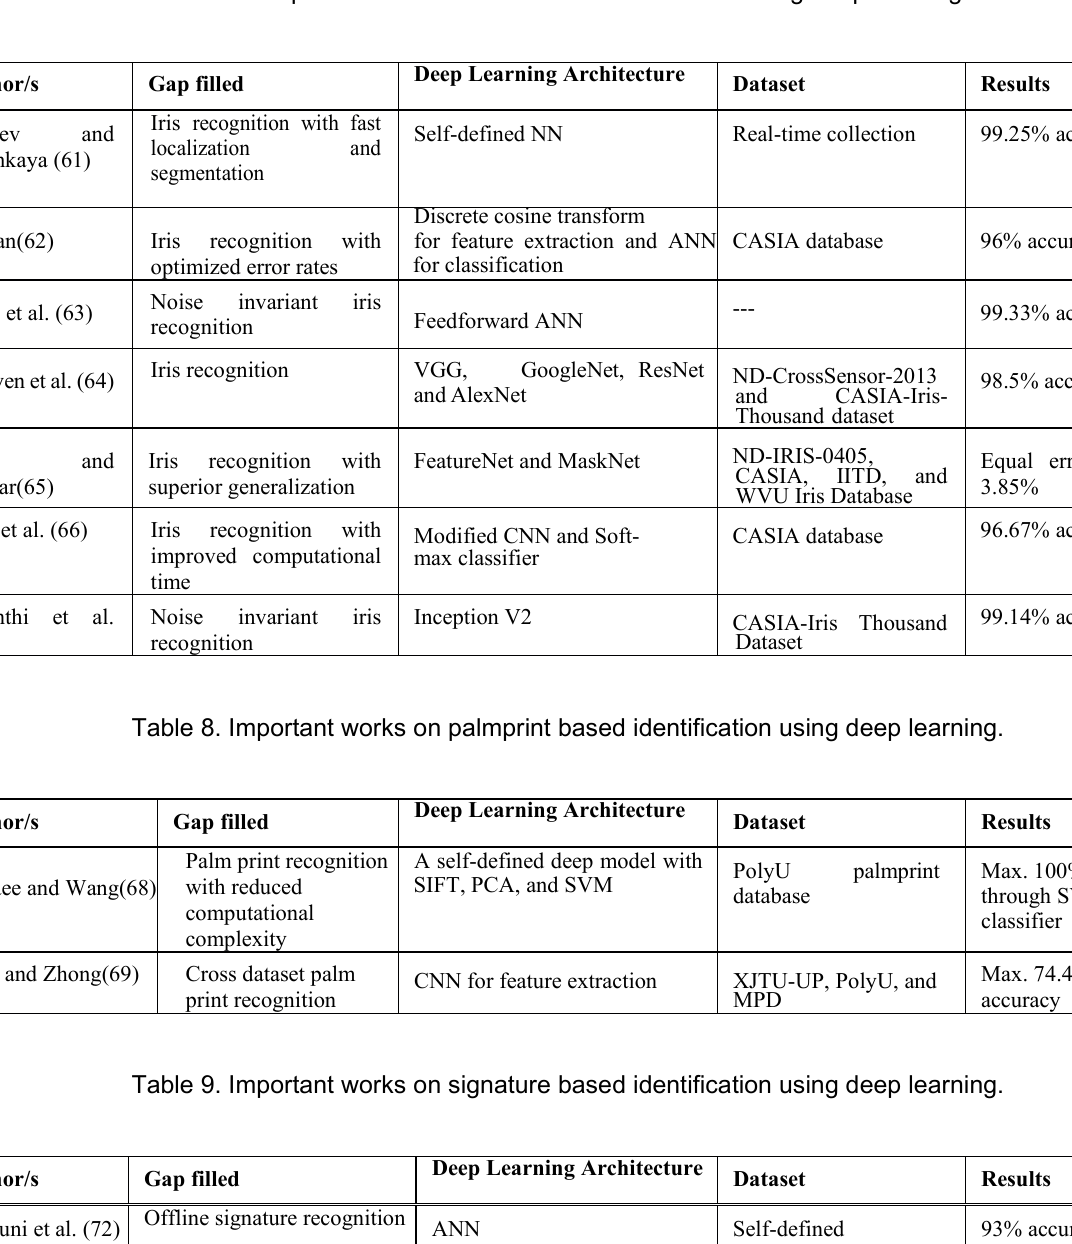
Table 7. Important works on Iris based identification using deep learning.